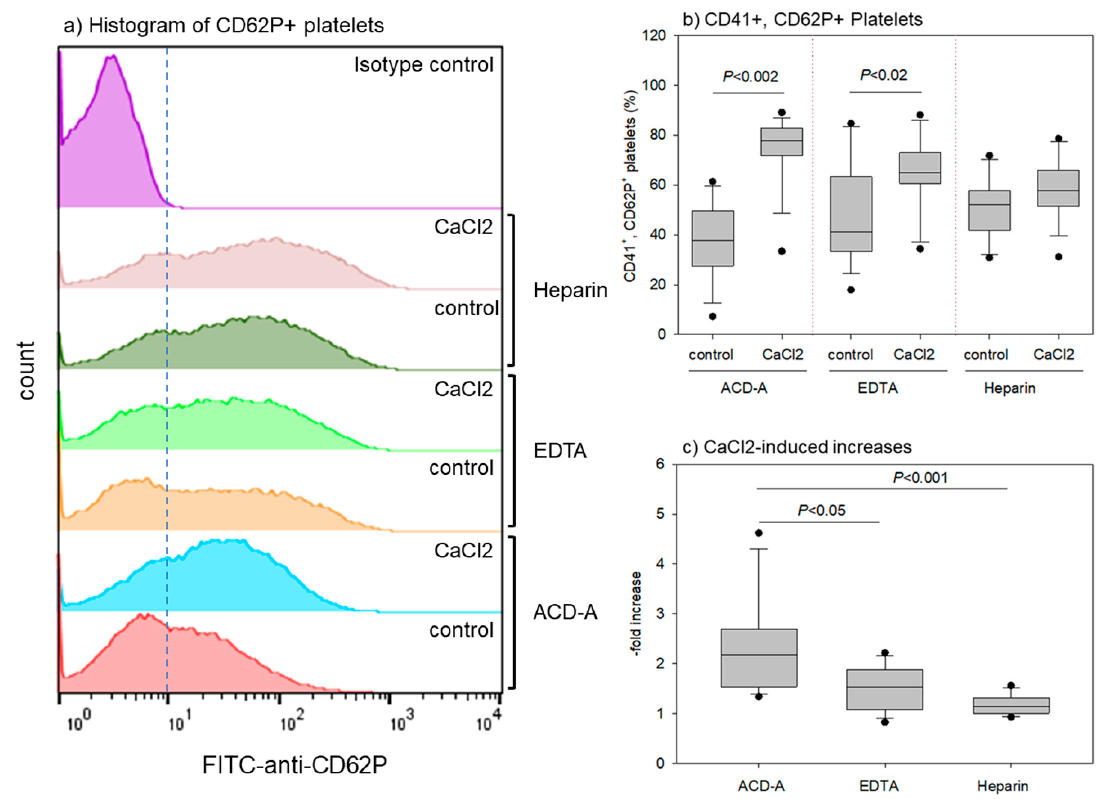
Figure 5. E ff ects of anticoagulants and CaCl 2 stimulation on CD62P expression in platelets. Pure-PRP samples were prepared from whole-blood samples stored for 24 h. Platelet suspensions in 0.1% BSA-supplemented PBS were stimulated with 0.1% CaCl 2 and fixed platelets were subjected to flow-cytometrical analysis. ( a ) Representative histograms of CD62P + platelets. ( b ) Percentages of CD41 + , CD62P + platelets. ( c ) CaCl 2 -induced increases in the double positive platelets. n = 14.